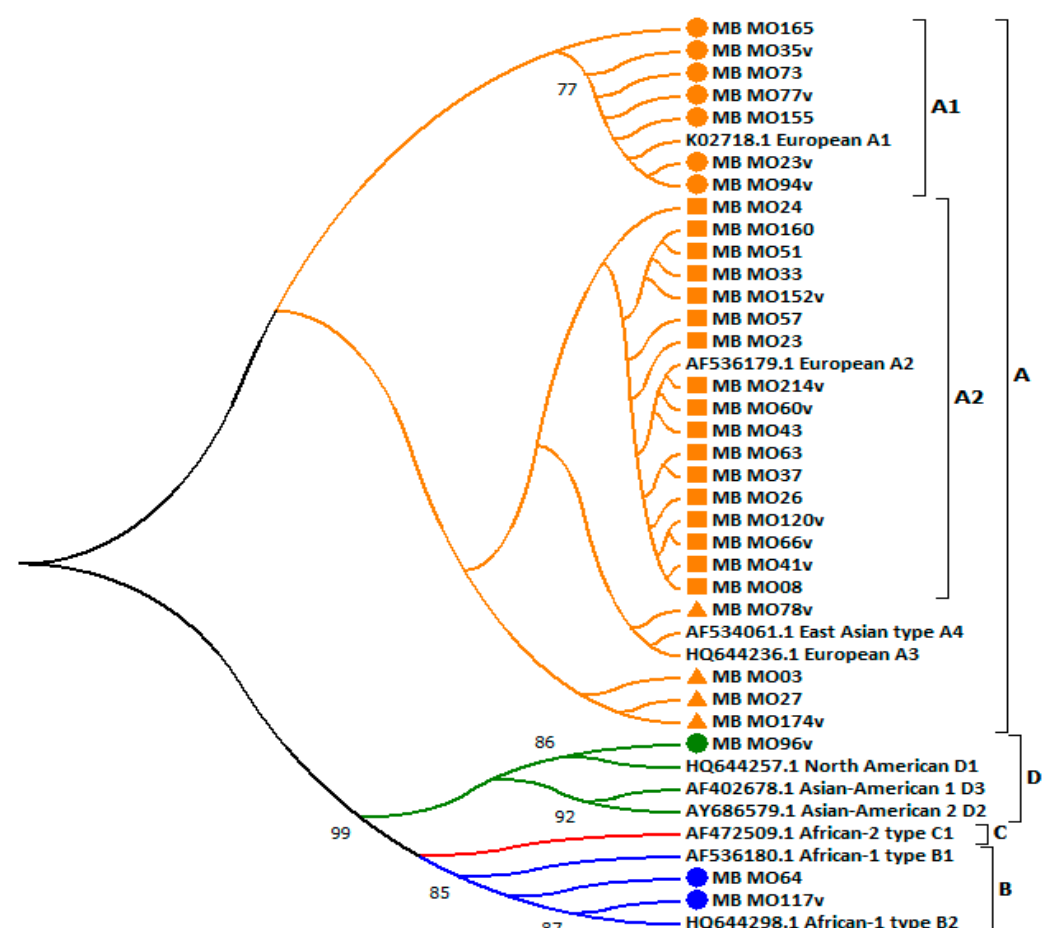
Figure 1. Evolutionary relationships of HPV16 sequences isolated from 31 women in the centre located in Lombardy. Sequences that belong to lineage A are highlighted in orange: the circles identify sequences clustered to sublineage A1, rectangles sequences clustered to sublineage A2 and triangles sequences clustered to an unclear A sublineage, respectively. Sequences that cluster to lineages B, C and D are reported in blue, red and green, respectively. Of these, sequences isolated from women enrolled in this centre are marked with a circle. The evolutionary history was inferred using the Neighbor-Joining method. The optimal tree with the sum of branch length = 0.08674820 is shown. The evolutionary distances were computed using the Kimura two-parameter method. The analysis involved 41 nucleotide sequences. Evolutionary analyses were conducted in MEGA7.